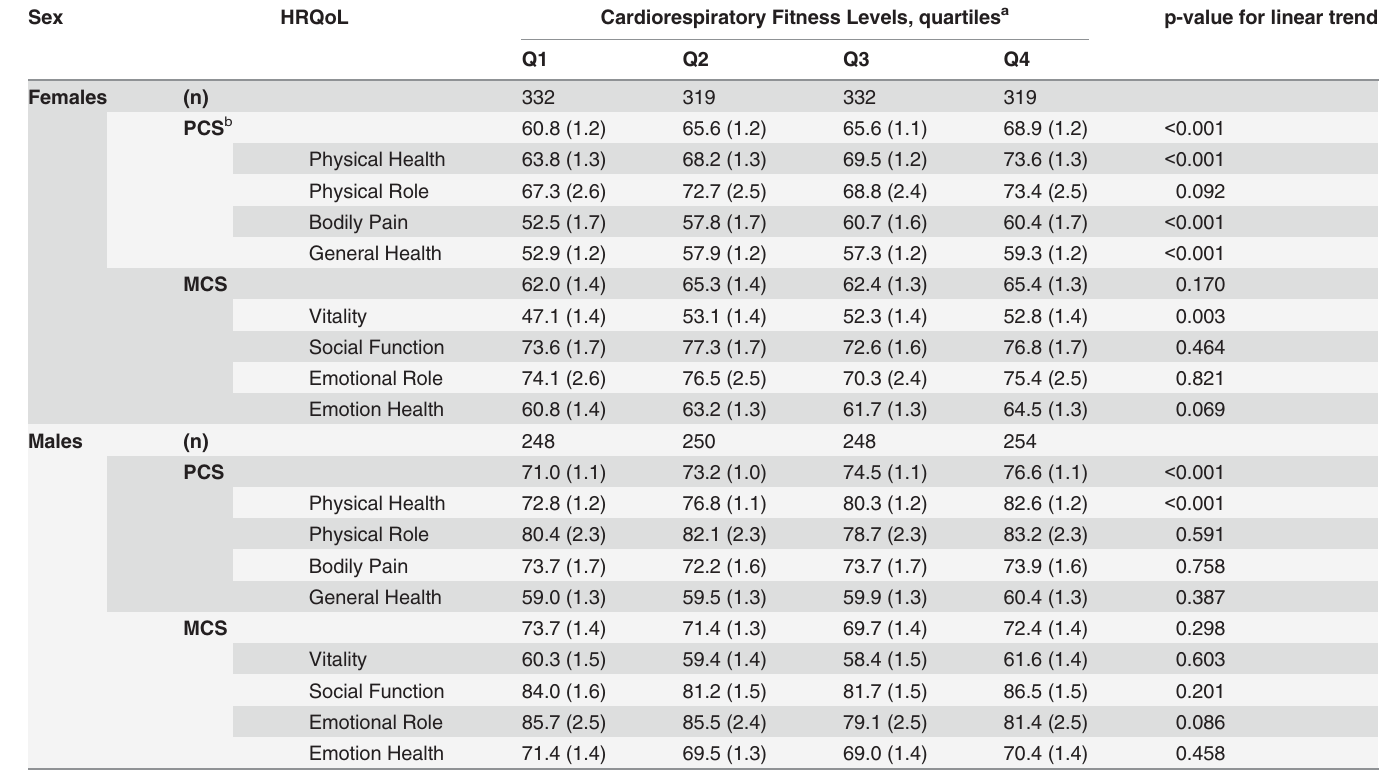
Table 2. Adjusted health-related quality of life (HRQoL) dimension scores by gender and cardiorespiratory fitness level.